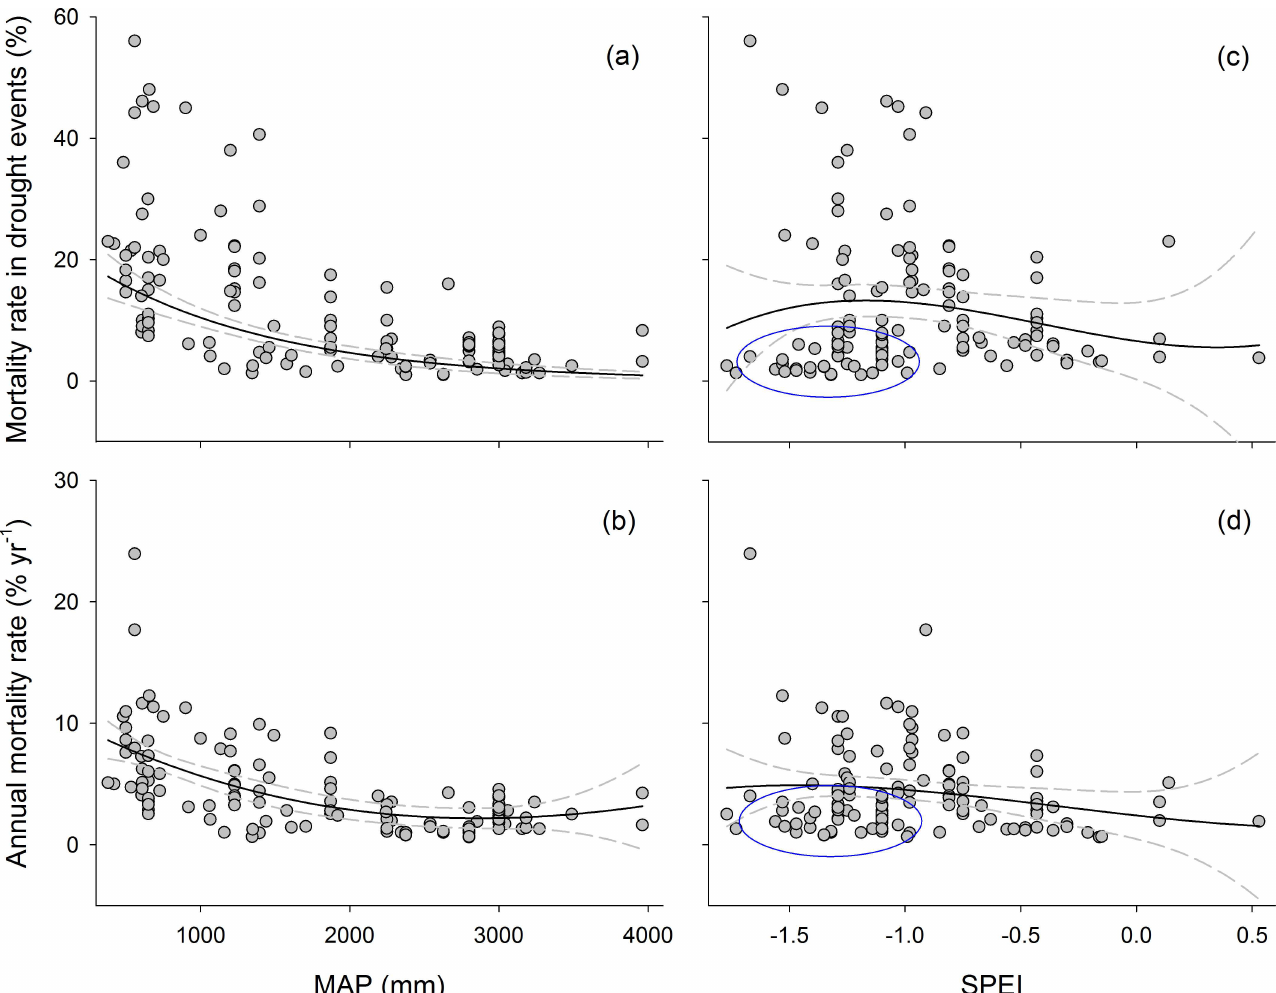
Fig 4. Sensitivity of mortality to drought for angiosperms. (a) and (b) showedrelationships betweentree mortality metrics and MAP. (c) and (d) showedrelationshipsbetweentree mortality metrics and SPEI. Dark-grey dots indicate droughts. Dark-grey dots indicate droughts. The best-fit models for each drought index and mortality-rate metric are shown, with the 95% bootstrapped confidenceintervals. MAP, mean annualprecipitation; SPEI, standardizedprecipitation-evapotranspirationindex. The blue ovals indicatethe lower tree mortality rate for